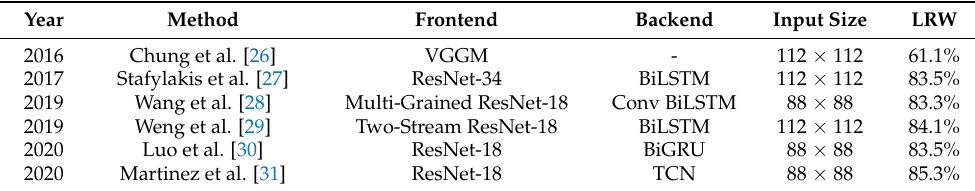
Table 2. Existing methods with different architectures trained on the LRW dataset. (LRW: Lip Reading in the Wild).